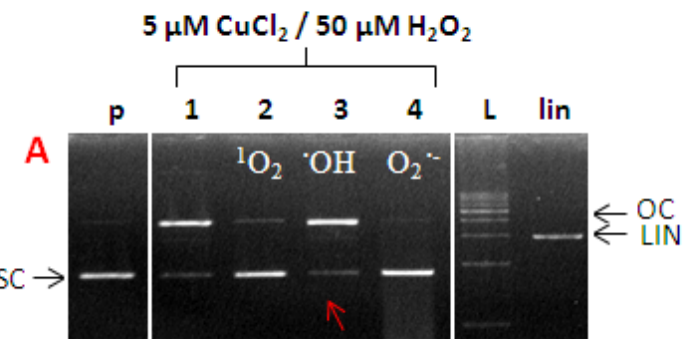
Figure 8. Electrophoretic profile of agarose gel (0.8%) containing 15 µ mol plasmid DNA pBSK+ with Cu (II) ions and hydrogen peroxide. Samples were loaded in the gel lanes in the following order: (p) pDNA-control; (1) pDNA + 5 µ M CuCl 2 , 50 µ M H 2 O 2 , (2–4) pDNA + 5 µ M CuCl 2 + 50 µ M H 2 O 2 plus (2) L-histidine, (3) DMSO, (4) SOD. (L) 1 kb DNA standard, (lin) pDNA linearized with EcoR1 endonuclease.